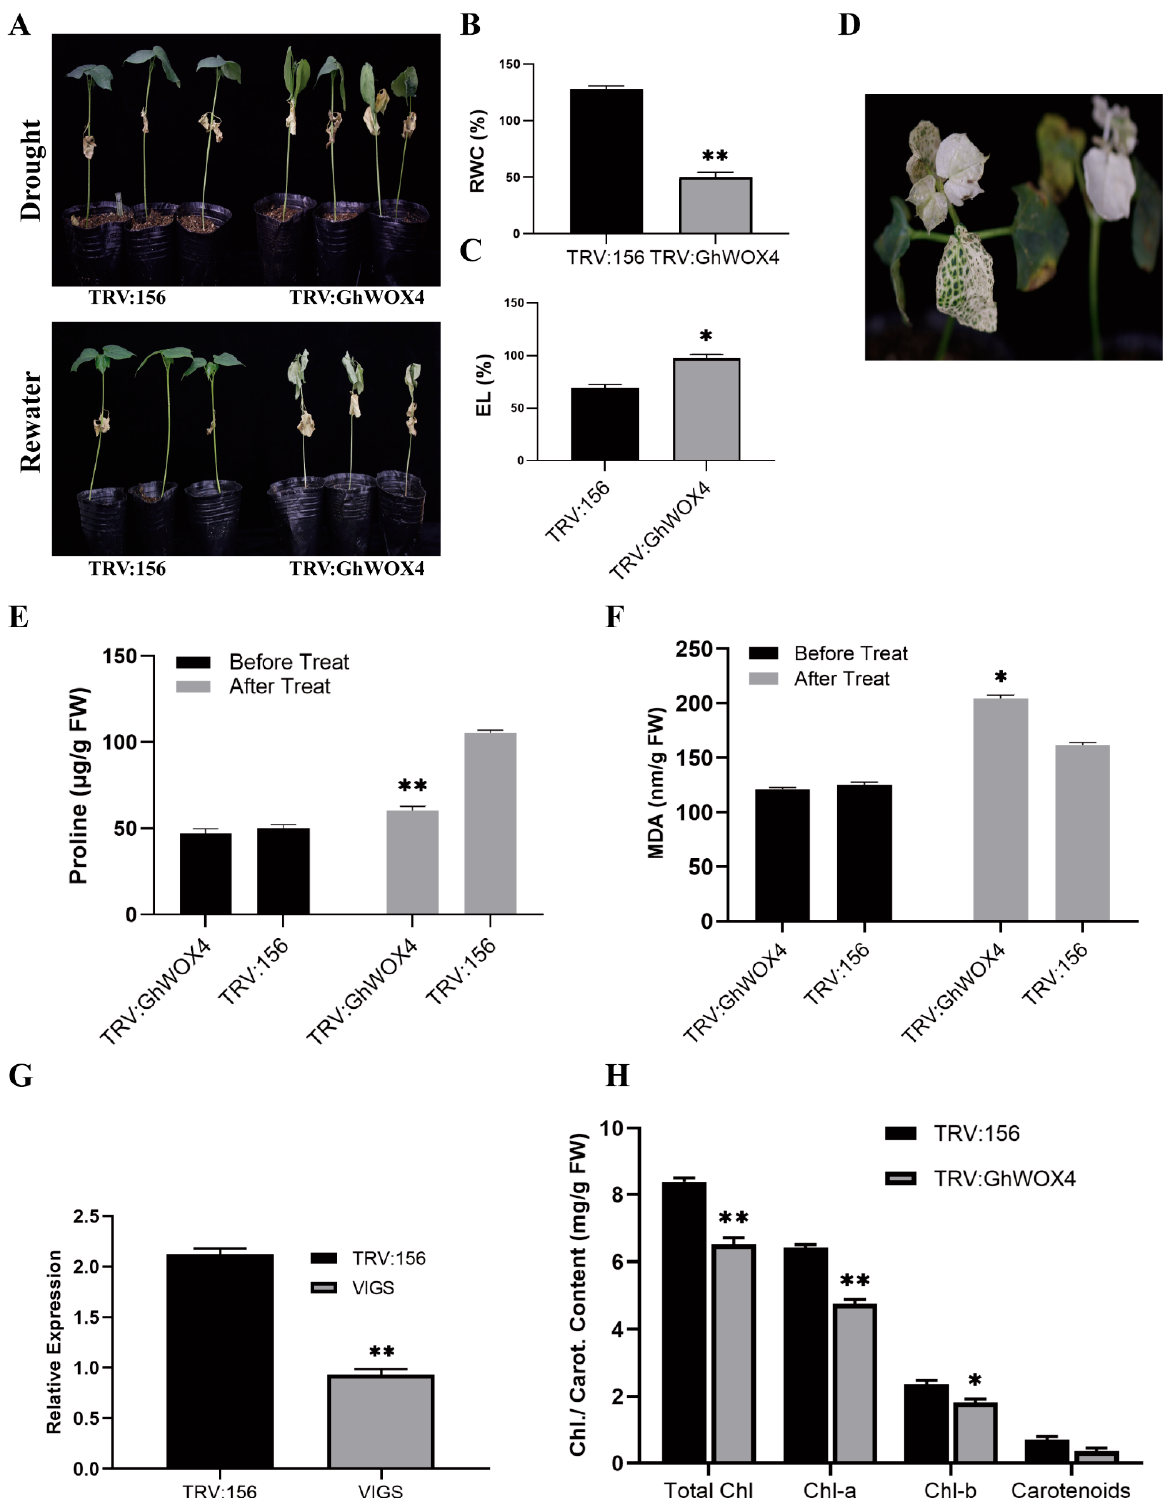
Figure 4. Silencing of GhWOX4 compromised cotton drought stress tolerance. ( A ) Soil grown virus-induced gene silencing (VIGS)-cotton plants subjected to natural drought treatment. ( B ) Measurement of relative water content percentage. ( C ) Electrolyte leakage percentage measurement. ( D ) Albino marker plant. ( E ) Proline content. ( F ) MDA content. ( G ) Relative silencing efficiency, VIGS, and control plants analyzed by q-RT PCR. VIGS expression was declined to less than half of the control plants ( H ) Chlorophyll content and carotenoids content. The data represent the means ± SE from three independent experiments, t-tests: * p < 0.05, ** p <